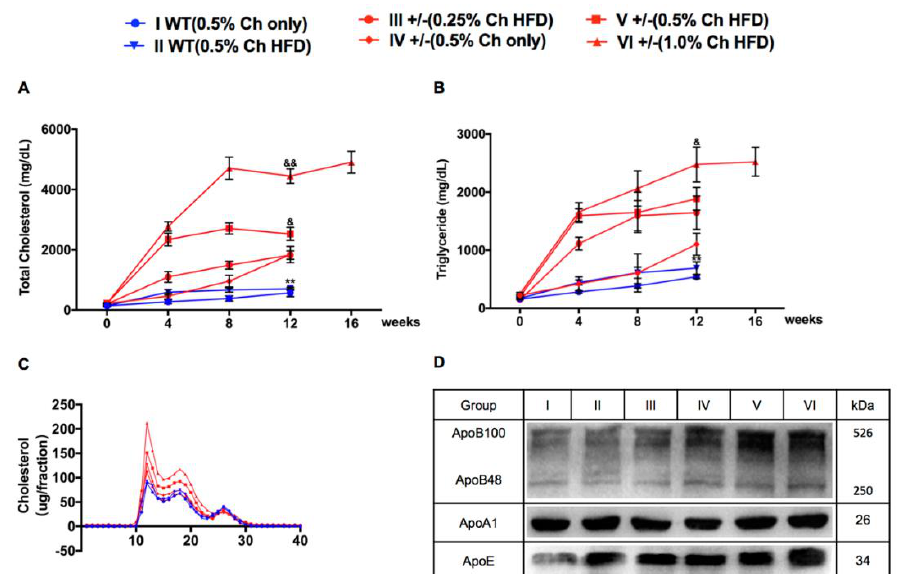
Figure 1. Plasma lipids and lipoprotein profiles in wild type (WT) and low-density lipoprotein receptor (LDLR) +/ − hamsters with high-cholesterol (HC) or high-cholesterol / high-fat (HCHF) diet. ( A , B ) Plasma total cholesterol ( A ) and triglyceride ( B ) were measured at the indicated time points in WT and LDLR +/ − hamsters on HC or HCHF diet for 12 or 16 weeks. n = 30 / group. ( C ) Fast protein liquid chromatography (FPLC) analysis of 500 µ L of pooled plasma lipoprotein profiles from WT and LDLR +/ − hamsters. ( D ) Western blot analysis of plasma apolipoprotein (Apo) B, ApoA1, and ApoE levels from WT and LDLR +/ − hamsters. & p < 0.05, && p < 0.01 vs. group III, ** p < 0.01 vs. group IV.